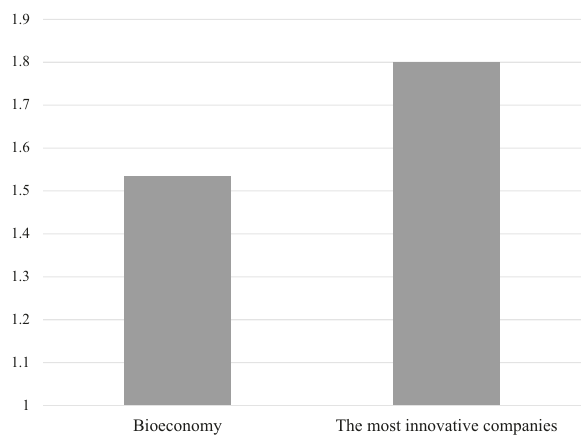
Fig. 2 Average degree of education using the mode approach. The mode approach illustrates that the average number of degrees in the boards of directors ’ is higher for the most innovative companies (1.8) compared to the bioeconomy companies